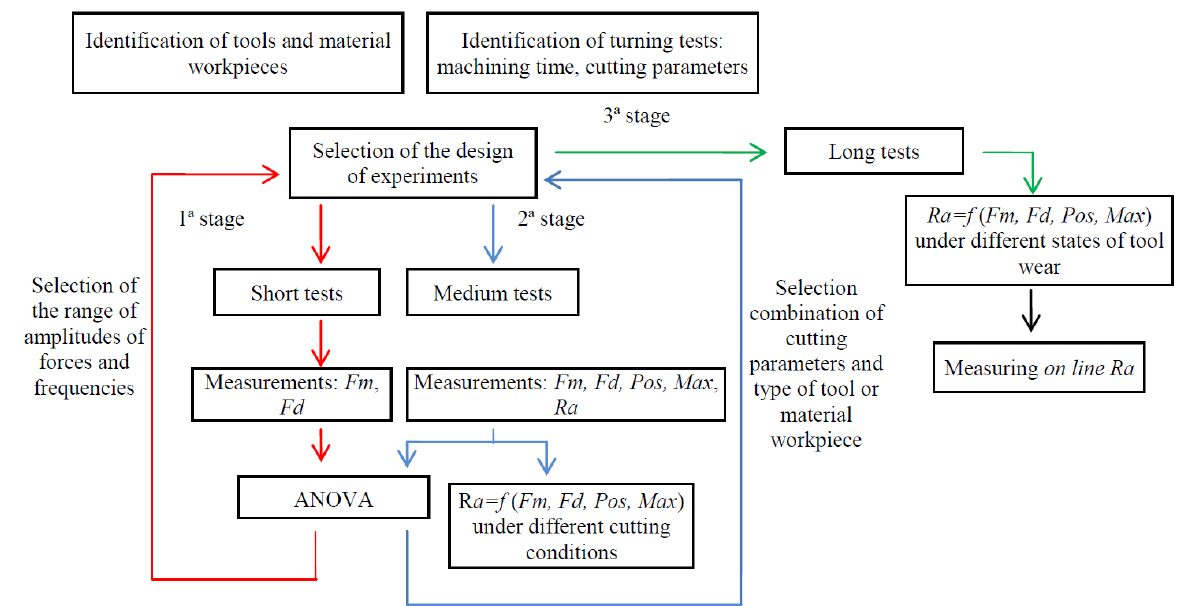
Figure 2. Schematic diagram of the proposed